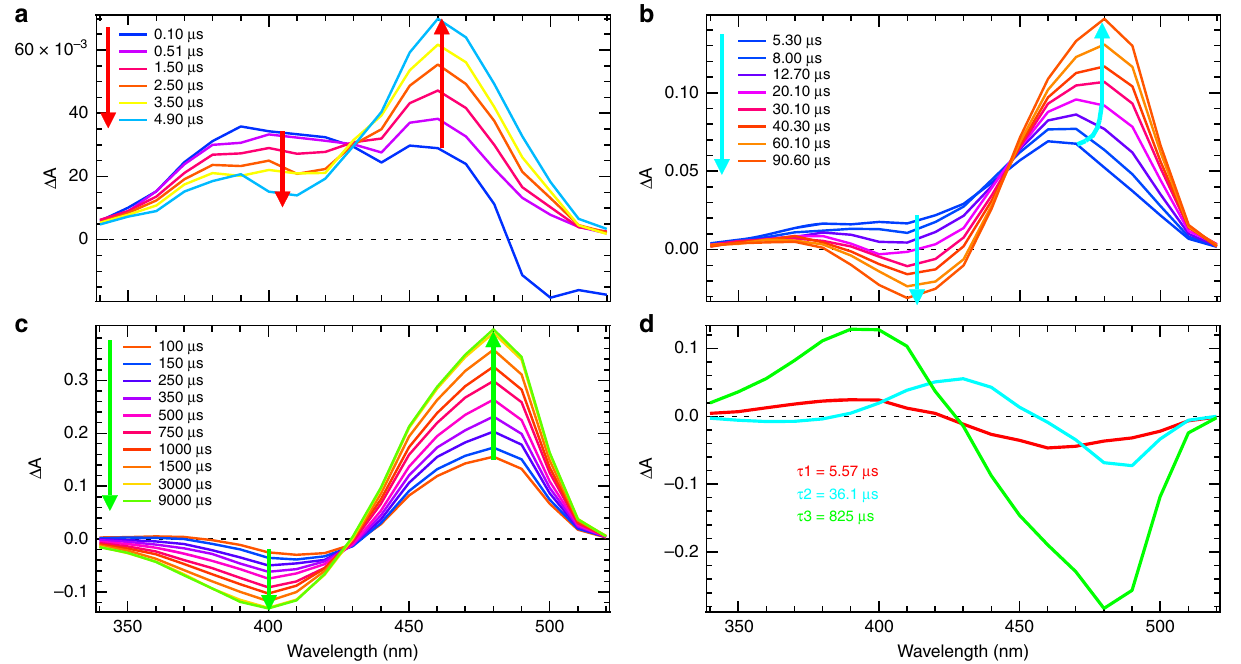
Fig. 2 Transient UV – Visible spectroscopy in H 2 O solution. Time-resolved difference absorption spectra of rsEGFP2 in H 2 O solution (50 mM HEPES pH 8, 50 mM NaCl) recorded after a 410 nm nanosecond excitation of the trans -protonated off-state in the time windows from 100 ns to 9 ms ( a – c ). The spectrum without laser excitation was subtracted to calculate the difference spectra. The colored arrows (red in ( a ), cyan in ( b ) and light green in ( c )) correspond to the three time constants (5.57, 36.1 and 825 µ s, respectively) identi fi ed by a global fi t analysis of kinetic traces for all wavelengths. d Decay associated spectra obtained by fi tting the kinetic traces in panels ( a – c ) for all wavelengths with a weighted sum of three exponential